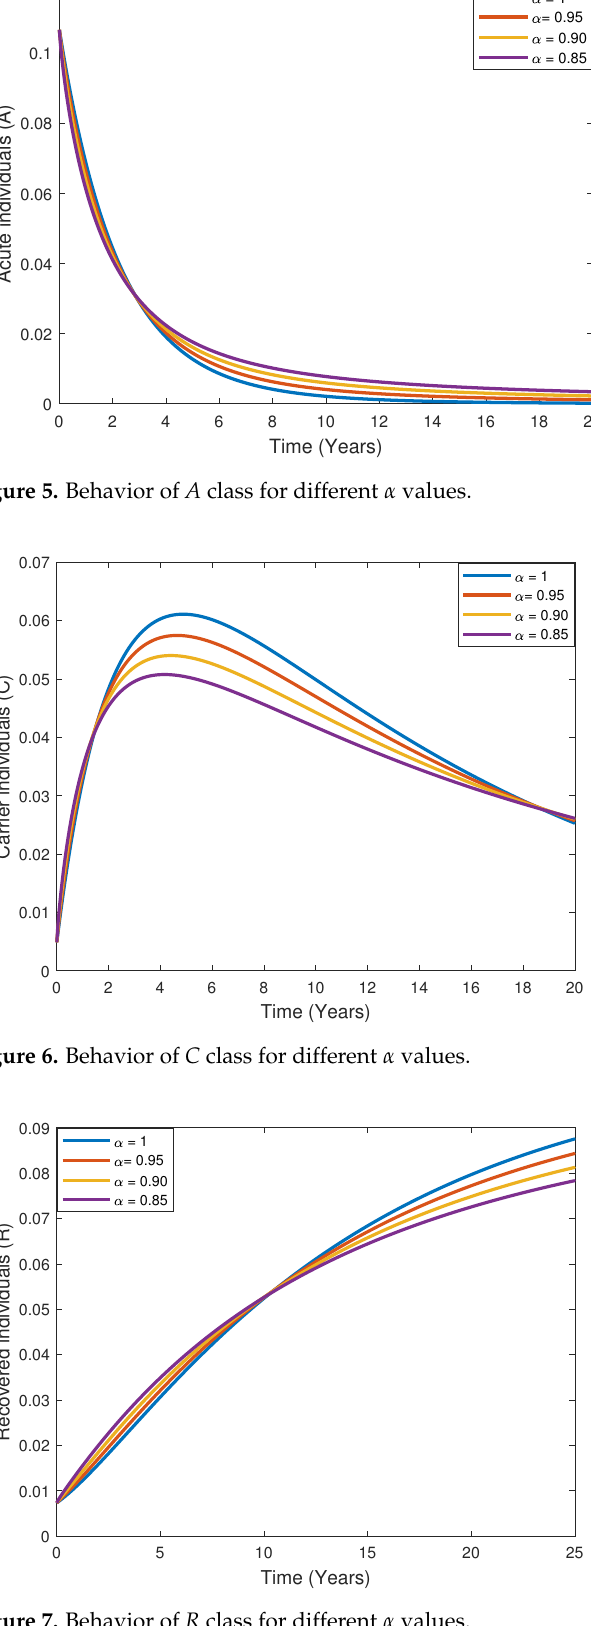
Figure 7. Behavior of R class for different α